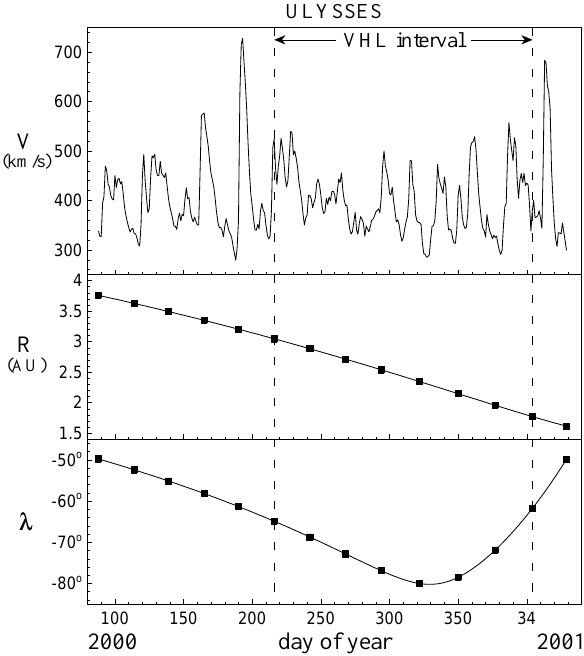
Fig. 2. The solar wind velocity ˇ and the Ulysses heliocentric dis- tance ˚ and heliographic latitude λ are plotted vs. time for the in- vestigated interval. Dashed lines delimit an interval at very high lat- itudes (VHL), where the ˇ curve does not exhibit prominent